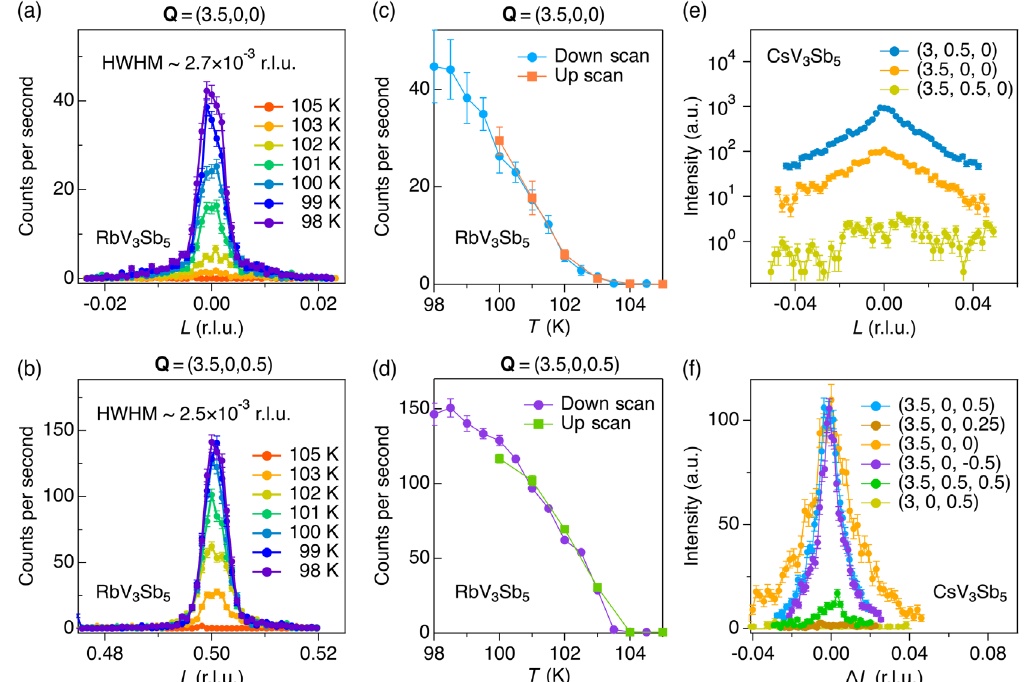
FIG. 2. 3D CDW determined by meV-resolution XRD. (a),(b) The temperature-dependent CDW peaks of RbV 3 Sb 5 at Q ¼ ð 3 . 5 ; 0 ; 0 Þ and (3.5, 0, 0.5). The CDW peak at half-integer L demonstrates a 3D CDW with 2 × 2 × 2 superstructure. The CDW peaks are extremely sharp along L , with HWHM of approximately 0.0025 r.l.u. at T ¼ 98 K. (c) and (d) show the extracted temperature-dependent CDW peak intensity at Q ¼ ð 3 . 5 ; 0 ; 0 Þ and (3.5,0,0.5),respectively. The peak intensity takes a sharp upturn at the CDWonset temperature of 103 K for RbV 3 Sb 5 , which is consistent with the specificheat measurement (see Appendix A). The absence of hysteresis is consistent with a second- order phase transition. CDW peaks in CsV 3 Sb 5 are shown in (e) and (f). The peak intensity at Q ¼ ð 3 ; 0 . 5 ; 0 Þ is over 10 times larger than the one at Q ¼ ð 3 . 5 ; 0 ; 0 Þ [panel (e)], consistent with larger structure factors at Q ¼ ð H; K þ 0 . 5 ; 0 Þ , H ¼ odd integer [8]. The absence of peaks at Q ¼ ð 3 ; 0 ; 0 . 5 Þ , (3.5, 0.5, 0), (3.5, 0, 0.25) confirms the same 2 × 2 × 2 superstructure in CsV 3 Sb 5 . The error bars in panels (a),(b),(e),(f) represent 1 standard deviation assuming Poisson counting statistics. The error bars in panels (c) and (d) denote the 2 σ returned from the pseudo-Voigt fittings that extract the peak